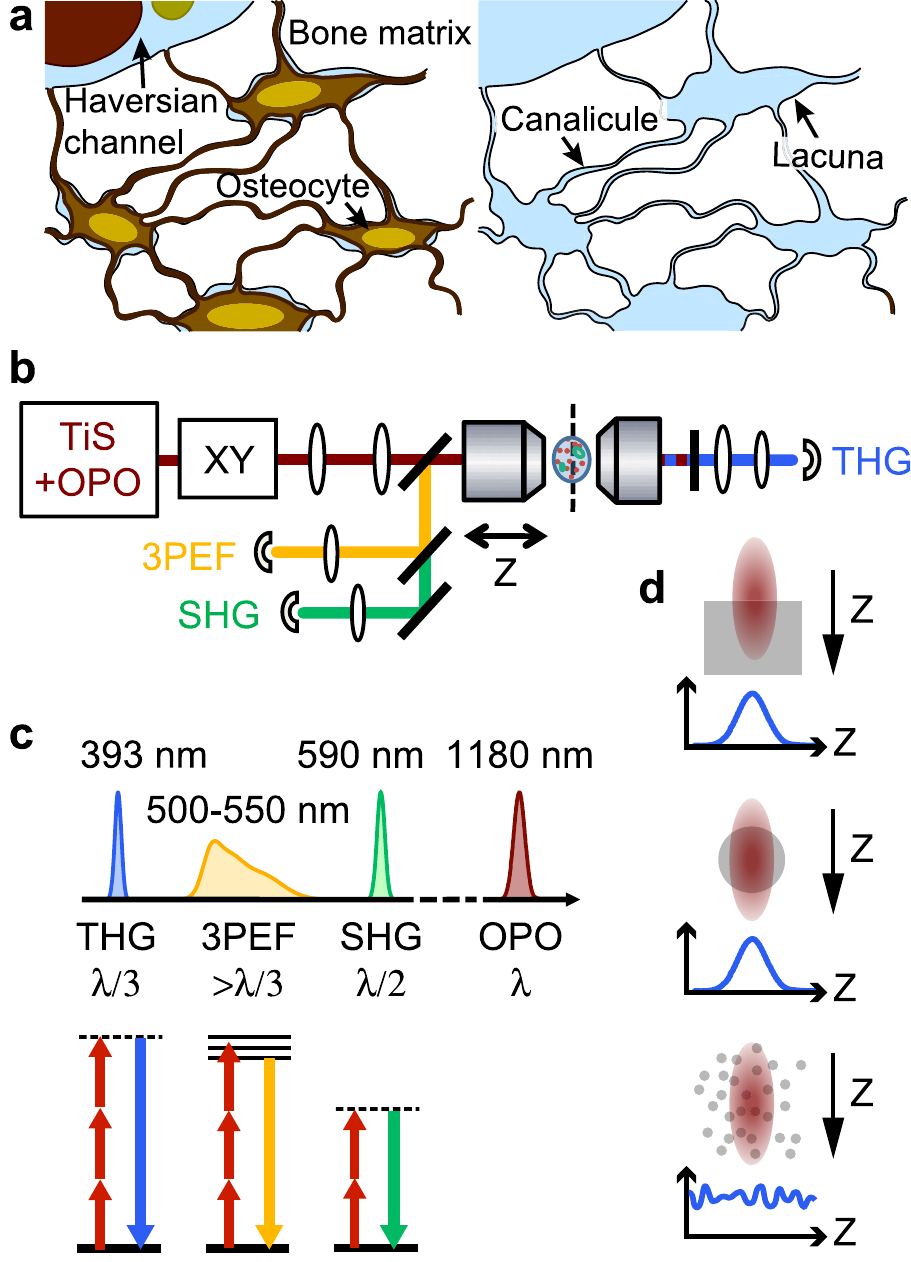
Figure 1. Lacuno-canalicular network and principles of THG-SHG-3PEF microscopy. ( a ) Schematic view of bone structure at the micrometric scale. Left, the network of interconnected osteocytes is embedded in the bone matrix and connected to Haversian channels containing nerves and blood vessels. Right, once the cells are removed, their previous location forms a network of porosities consisting of lacunae and canaliculi, forming the LCN. ( b ) Scheme of the microscope used for nonlinear imaging. An optical parametric oscillator (OPO) pumped by a titanium-sapphire laser (Ti:S) is focused and scanned inside the sample using galvanometric mirrors (XY) and a high-NA objective. Third harmonic generation (THG), second harmonic generation (SHG) and three-photon excited fluorescence (3PEF) signals are excited simultaneously and detected on photomultiplier tubes after spectral separation. 3PEF and SHG are epidetected while THG is collected in transmission through the sample. ( c ) Spectral representation (top) of the signals created by OPO excitation at λ = 1180 nm. THG (resp. SHG) is generated at a third (resp. half) of the excitation wavelength, while 3PEF is emitted in a broad range of wavelengths longer than λ /3. Bottom, corresponding simplified Jablonski diagrams. Dashed lines, virtual states. ( d ) THG signal for various sample geometries relevant for bone imaging. Interfaces (top) and heterogeneities down to a fraction of the size of the focal volume give rise to a localized signal, while a uniform medium produces no signal. Smaller size, randomly distributed heterogeneities create a non-zero, fluctuating